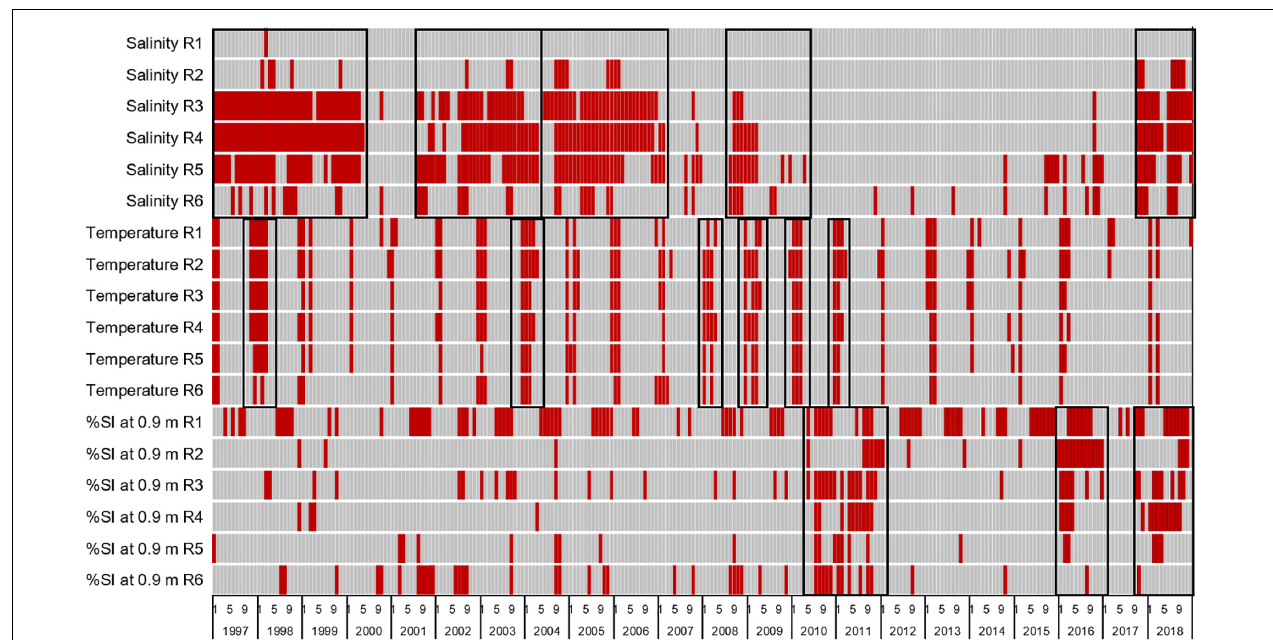
FIGURE 11 | Heatmap with red bars indicating times when seagrass was stressed by salinities below 23 psu, water temperatures below 20 ◦ C, or less than 27% of subsurface irradiance (%SI) reaching 0.9 m for reaches 1–6. Black boxes highlight periods of widespread increased